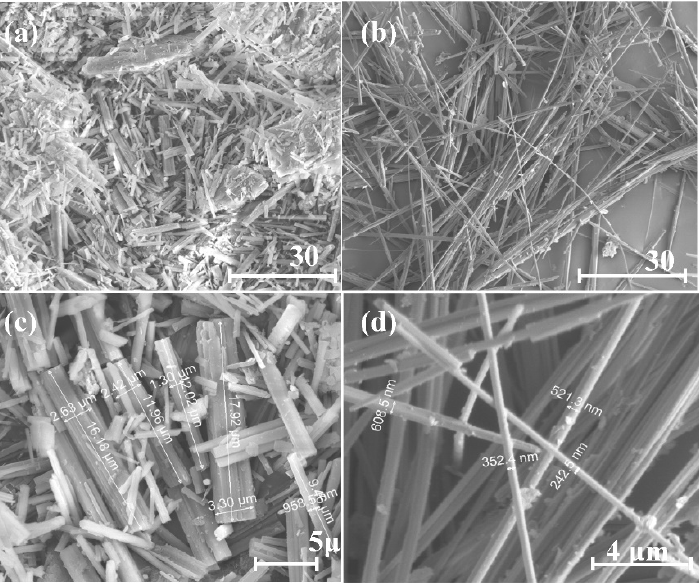
Figure 11. ESEM photos of samples before and after stabilizing: ( a , c ) before stabilizing; ( b , d ) after stabilizing. Figure 11c,d are the enlarged pictures of Figure 11a,b, respectively.